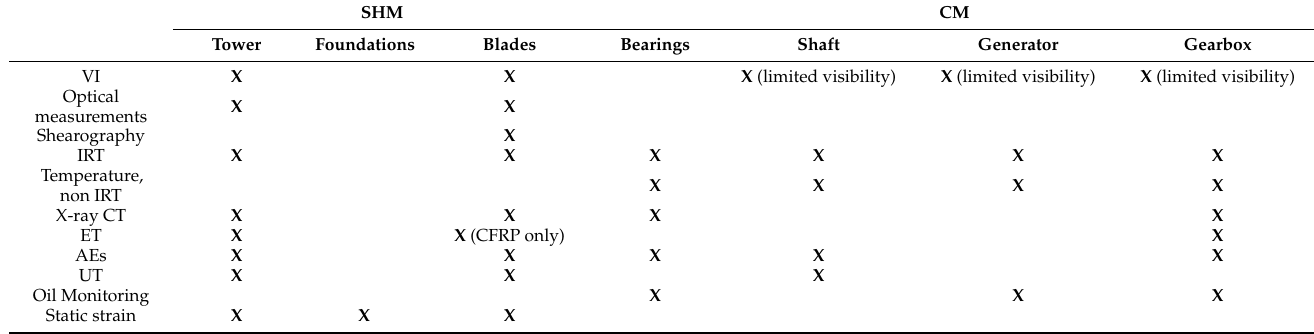
Table 12. Most common monitoring strategies for the different load-bearing and rotating components of a wind turbine, according to the literature review (in particular [61,326,327]) and considering both on- and off-site (laboratory)